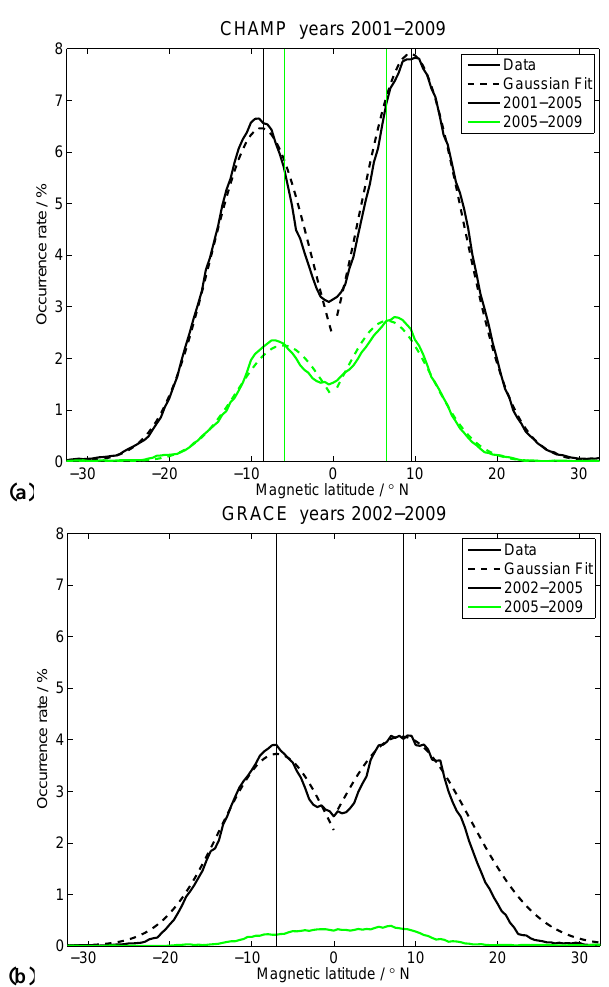
Fig. 9. Occurrence rates of EPBs versus magnetic latitude based on CHAMP PLP (top) and GRACE KBR (bottom) observations for the two solar activity